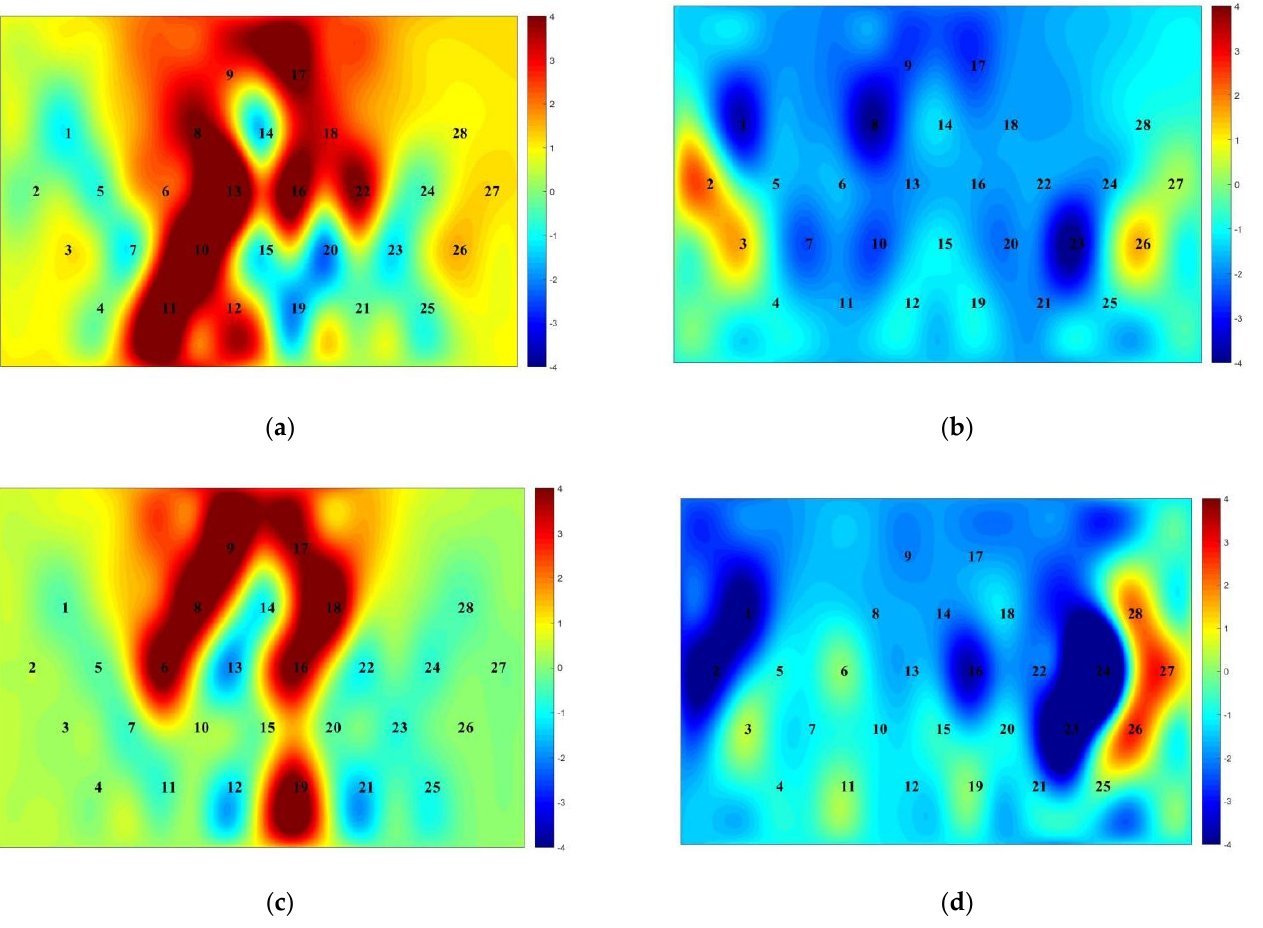
Figure 10. Activation map of the prefrontal lobe of college students of different genders before and after orienteering intervention in the experimental group. ( a ) male pre ‐ test; ( b ) male post ‐ test; ( c ) female pre ‐ test; ( d ) female post ‐ test. The numbers represent the 28 channels of the prefrontal lobe and the colors represent the level of activation of the prefrontal lobe, with redder colors representing higher activation and bluer colors representing lower activation.